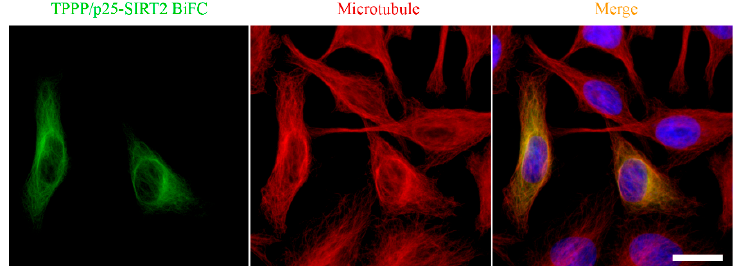
Figure 5. Localization of the SIRT2-TPPP/p25 complex on the microtubule network [64]. Scale bar: 10 μ m.